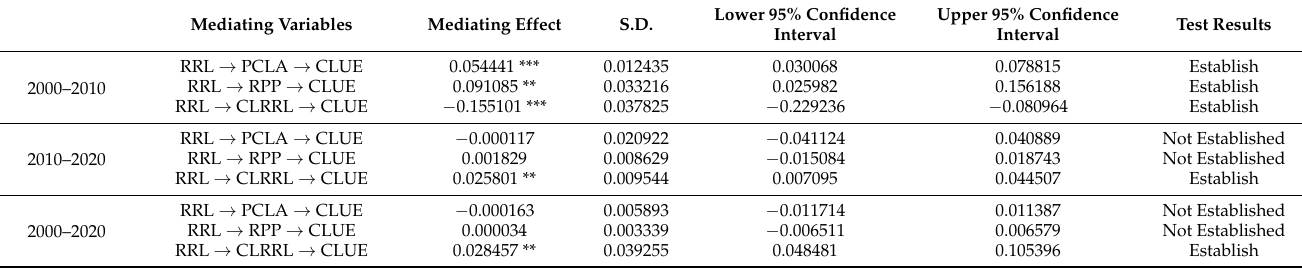
Table 9. Bootstrap mediating effect test